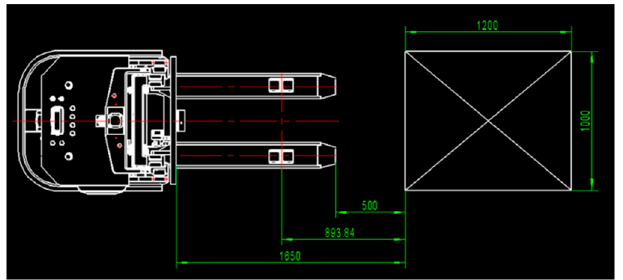
Figure 10. The pose relationship between the 3D vision sensor and the pallet.